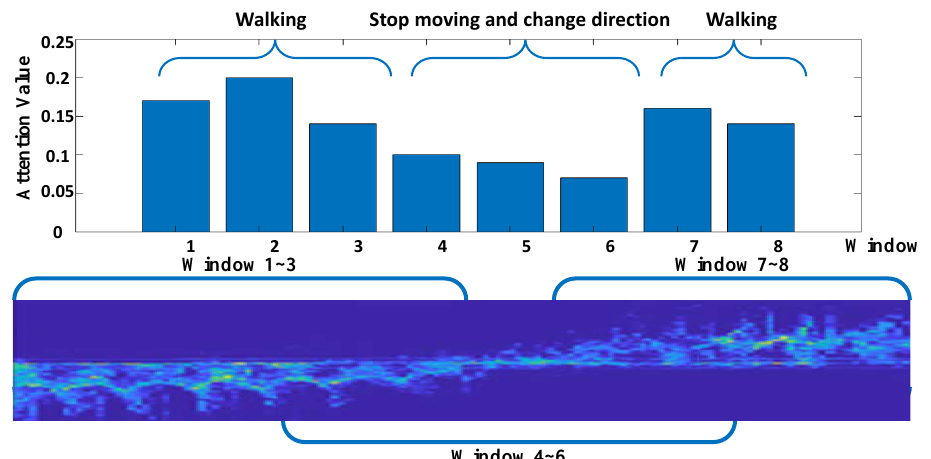
Figure 5. Attention weights according to temporal windows in TWA. The 8 windows are generated via traversing MD signatures with a sliding window composed of 45 time stamps and 15 strides.